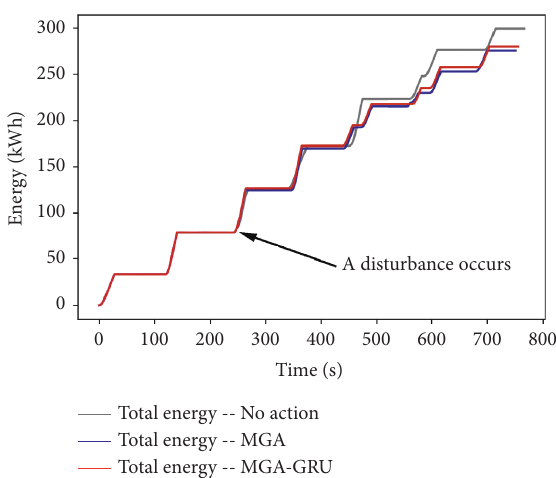
Figure 8: Changes in net energy consumption with different strategies under a 13.45 s dwell disturbance. Table 4: The rescheduled timetable with the MGA-GRU method in the two-train system. Section